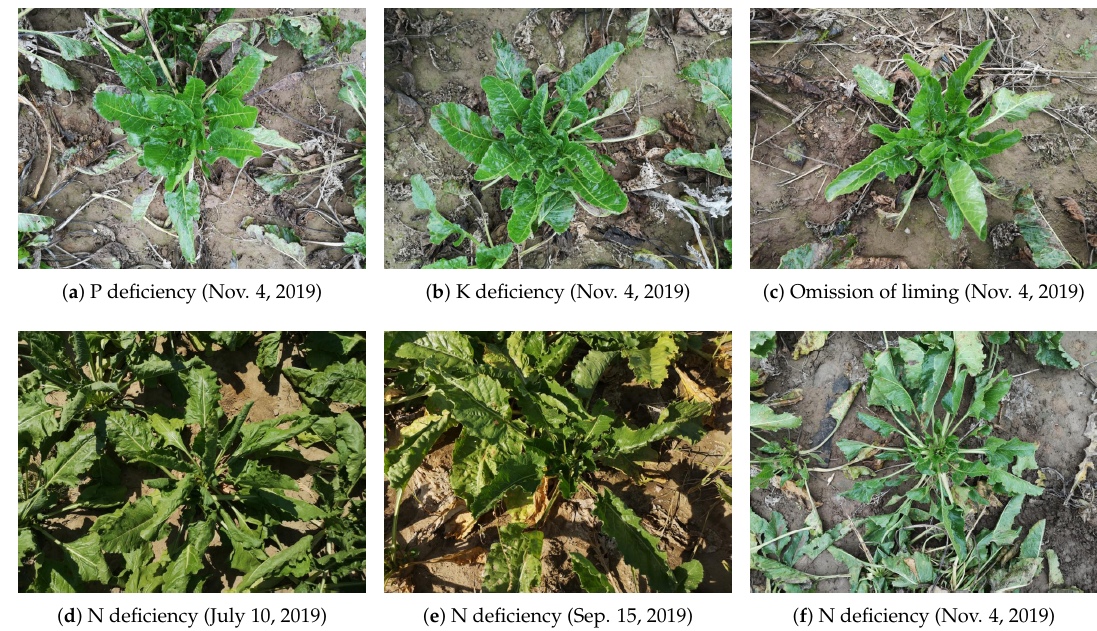
Figure 1. Example images. ( a – c ) Sugar beets with similar visual appearance but different nutrient deficiencies, indicating low inter-class visual variation. ( d – f ) Sugar beets with totally different visual appearance but all subjected to N deficiency, indicating high intra-class visual